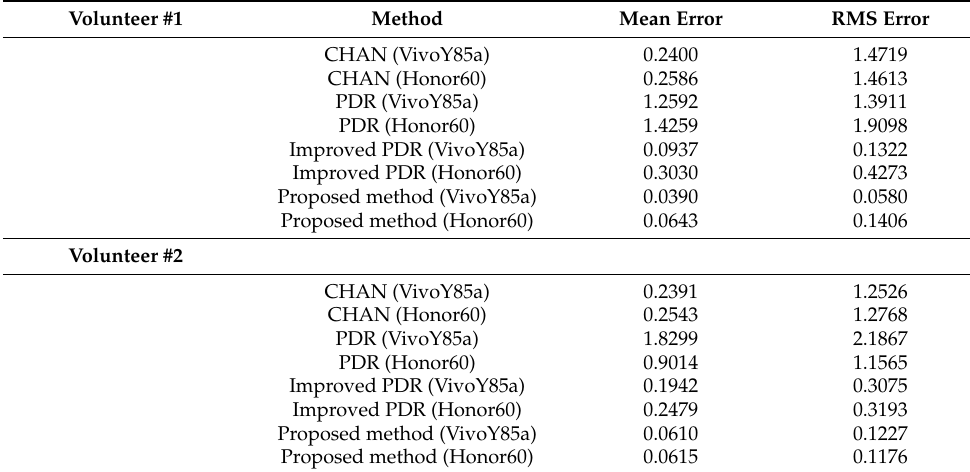
Table 8. Localization error results between CHAN, PDR, improved PDR, and the proposed method with Honor60, VivoY85a, and two different height pedestrians in the second scene